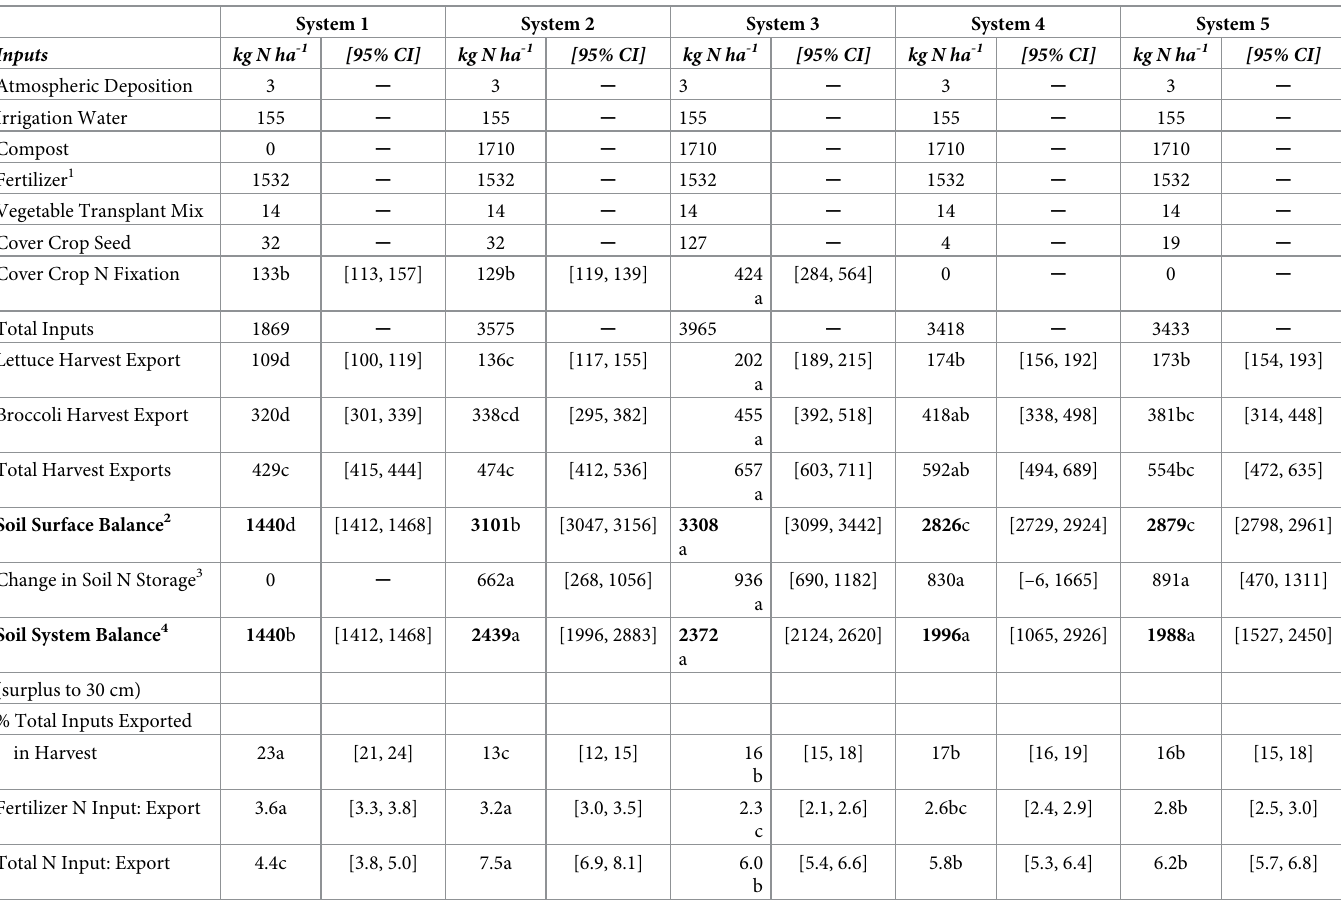
Table 3. Cumulative nitrogen inputs, exports and mass balances for 5 organic vegetable systems over eight years in Salinas, CA. Systems differed by annual compost additions (0 vs. 7.6 Mg ha -1 , oven-dry basis, before each vegetable crop), cover crop type (legume-rye, mustard, or cereal rye alone) and cover cropping frequency